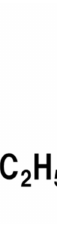
Figure 5. Chemical structure of ethyl- α - D